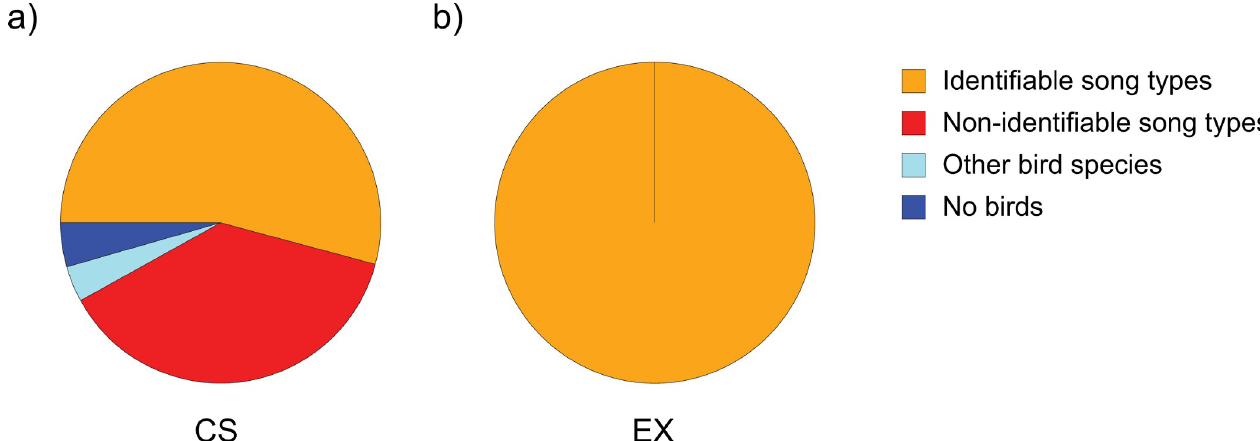
Fig 4. Comparison of defined recording categories for 2019, based on a) 5,679 citizen science recordings (CS) with smartphones via the ’Naturblick’ app and b) six expert recordings (EX) with high-quality microphones. The categories are displayed in different colours (red: one song type was in its entirety recognizable by syllables and elements in the spectrograms, orange: some syllables or elements were not clearly shown in the spectrograms, light blue: other bird species and dark blue: no birds). https://doi.org/10.5281/zenodo.4817236.